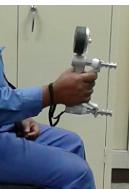
Figure 1. Measurement of the grip hand force using the JAMAR dynamometer with the second handle position (span = 45 mm).